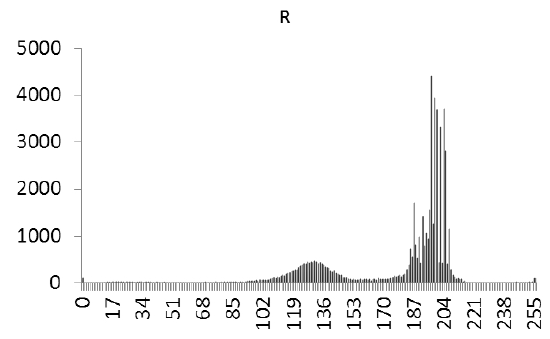
Figure 17. Statistical chart of R value distribution of the original image.